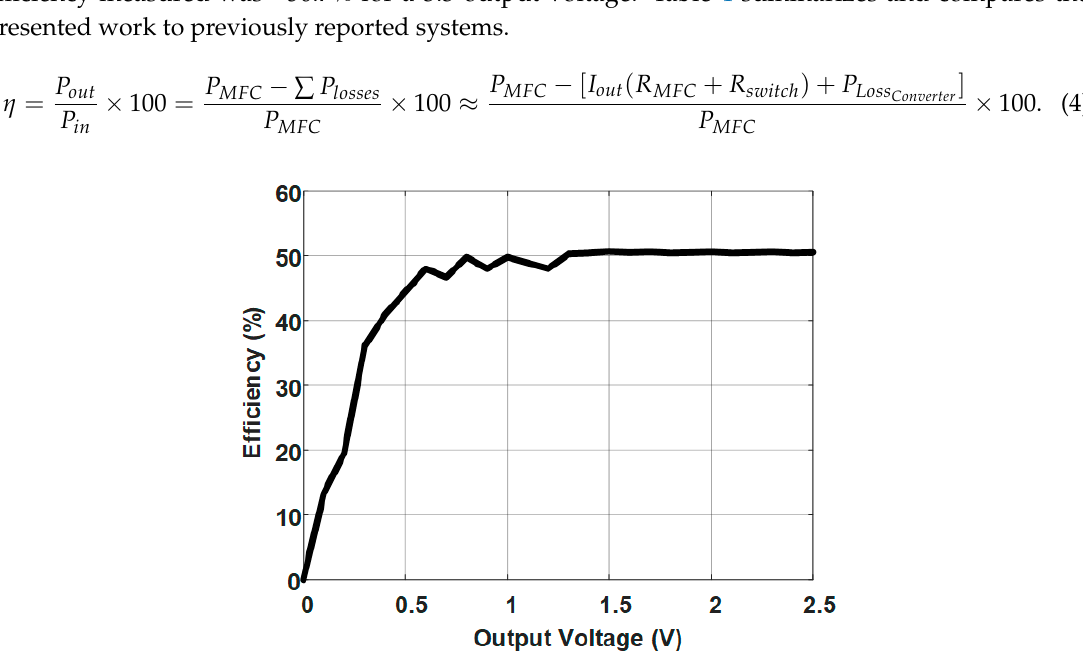
Figure 11. Measured Efficiency versus Output Voltage.